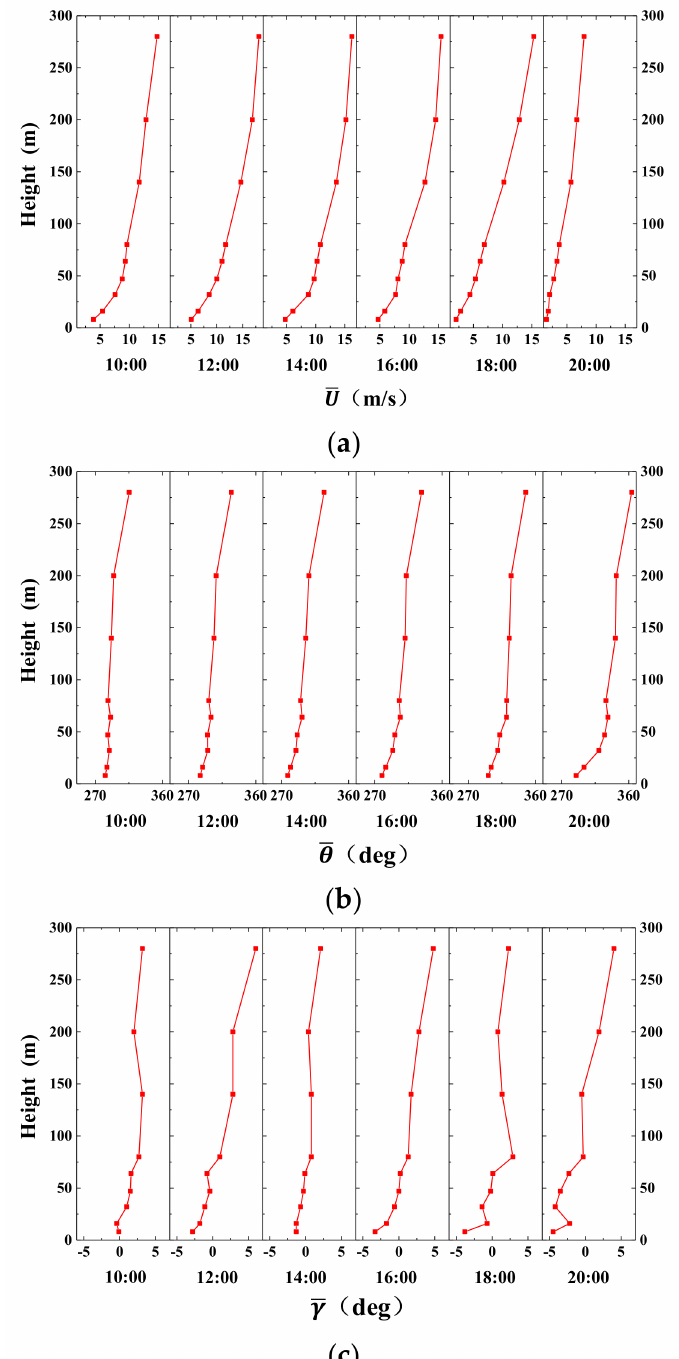
Figure 10. The profile variation of the 10-min mean wind speed ( a ), hotizontal direction ( b ) and wind angle of attack ( c ) on 10 October